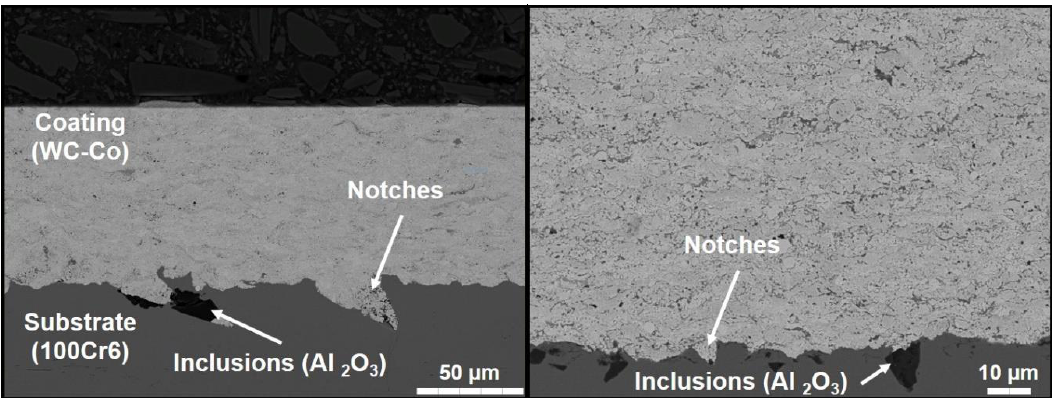
Figure 1. Interfacial bonding of sandblasted substrate surface.